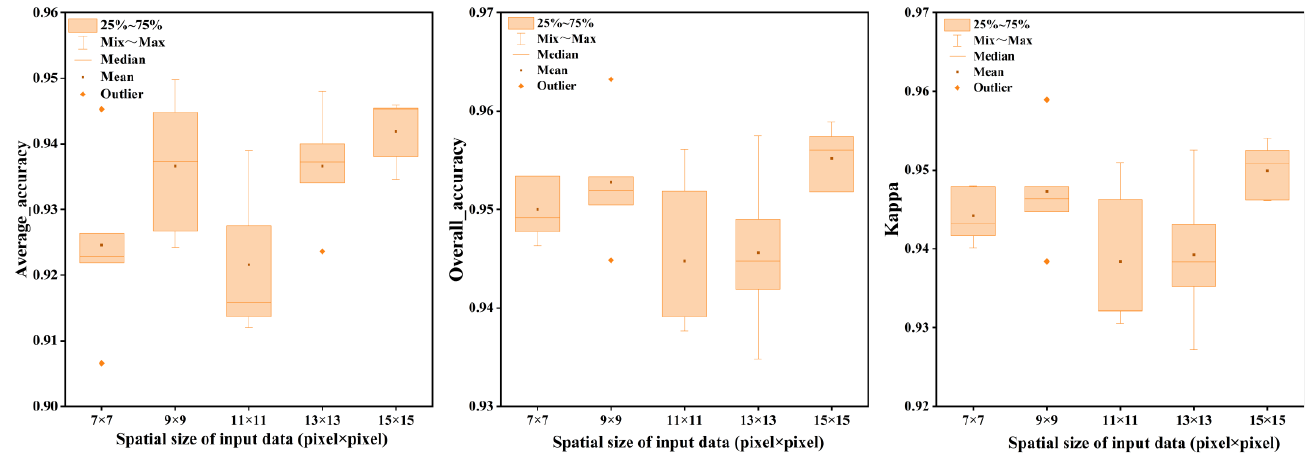
Figure 13. Impact of different input sizes on 3D-1D-CNN for Houston